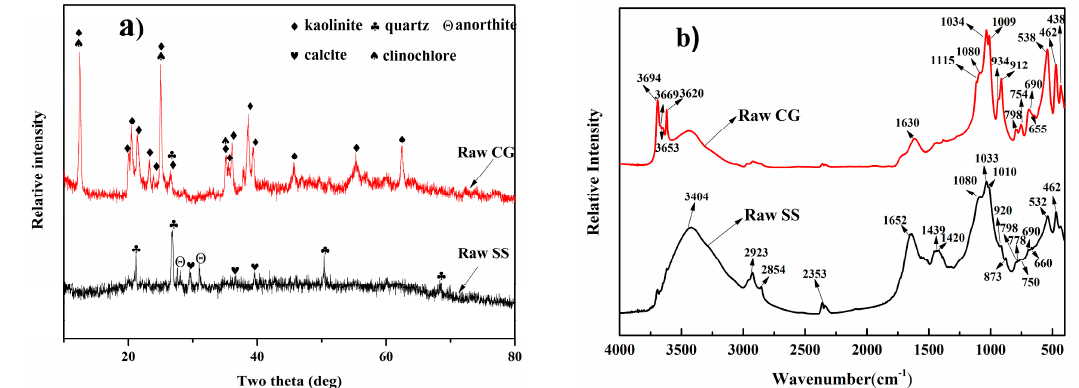
Figure 1. The X-ray diffraction (XRD) patterns and Fourier transformation infrared (FT-IR) spectra of raw coal gangue (CG) and sewage sludge (SS): ( a ) XRD patterns; and ( b ) FTIR spectra.